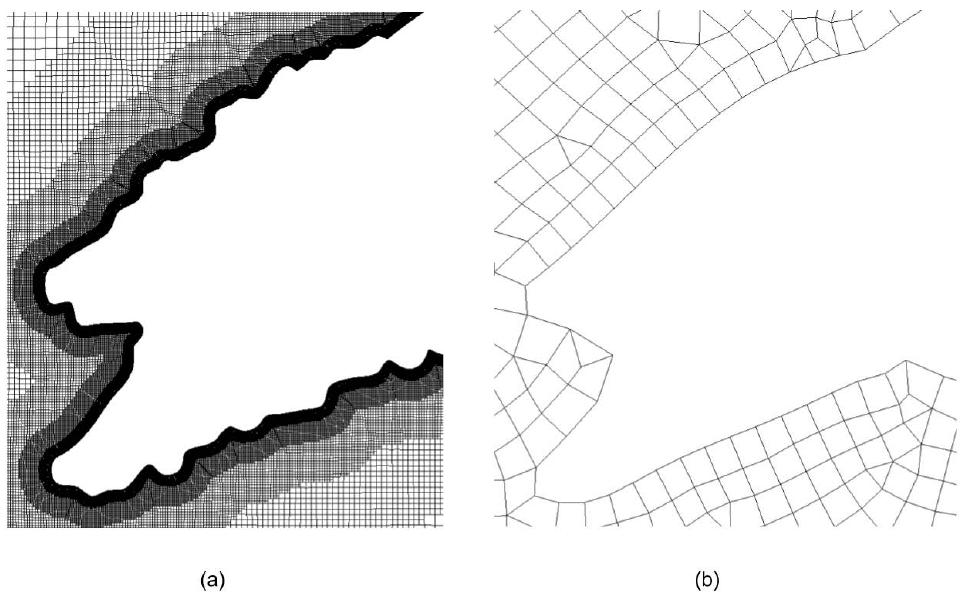
Figure 6. Comparison between ( a ) fine (with fully resolved roughness) and ( b ) coarse (with RWFs) grids of profile 2.